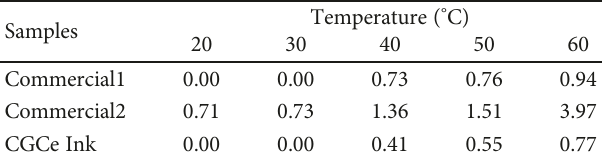
Table 5: Rate of losing of di ff erent